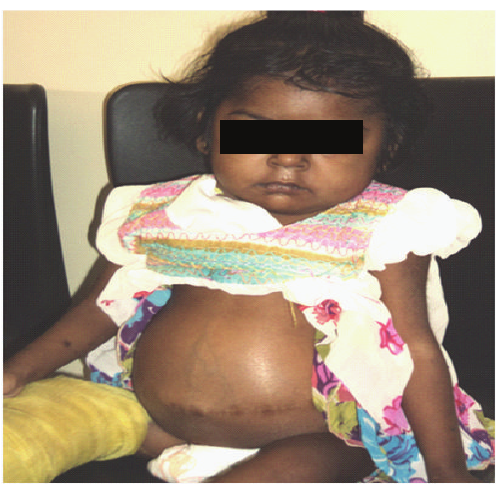
Figure 1: Proband with hepatomegaly at 4 years of